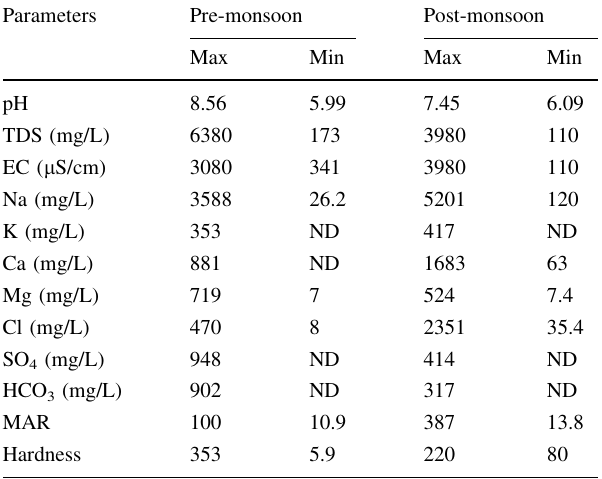
Table 1 Chemical analysis results of water samples for pre- and post-monsoon season Parameters